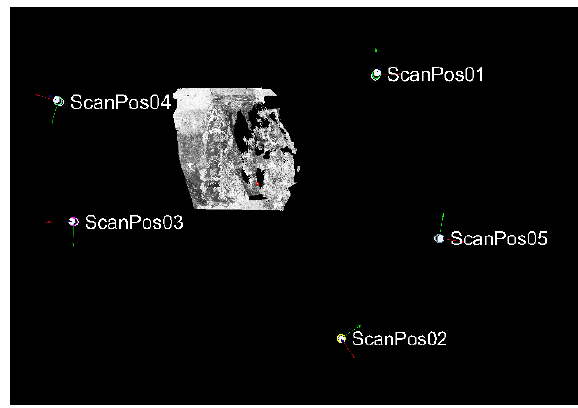
Figure 3. The positions of the